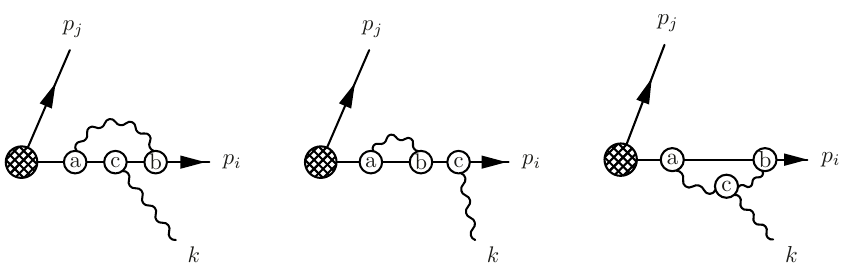
Figure 3 . Diagram classes modifying the soft emission process with loop correction to a single collinear leg. Collinear interaction vertices are power-suppressed by at least one order in λ , so a, b ≥ 1 , suppressing the collinear loop by λ 2 . For soft loops, one can fix soft light-cone gauge in the direction of the collinear leg, effectively decoupling the soft modes. This means that a, b ≥ 2 and the soft loop is suppressed by λ 4 . In addition, the soft loop is scaleless unless the graviton is emitted via a purely-soft vertex, as depicted in the last diagram. This process is further suppressed by c ≥ 2 , yielding a total suppression by λ 6